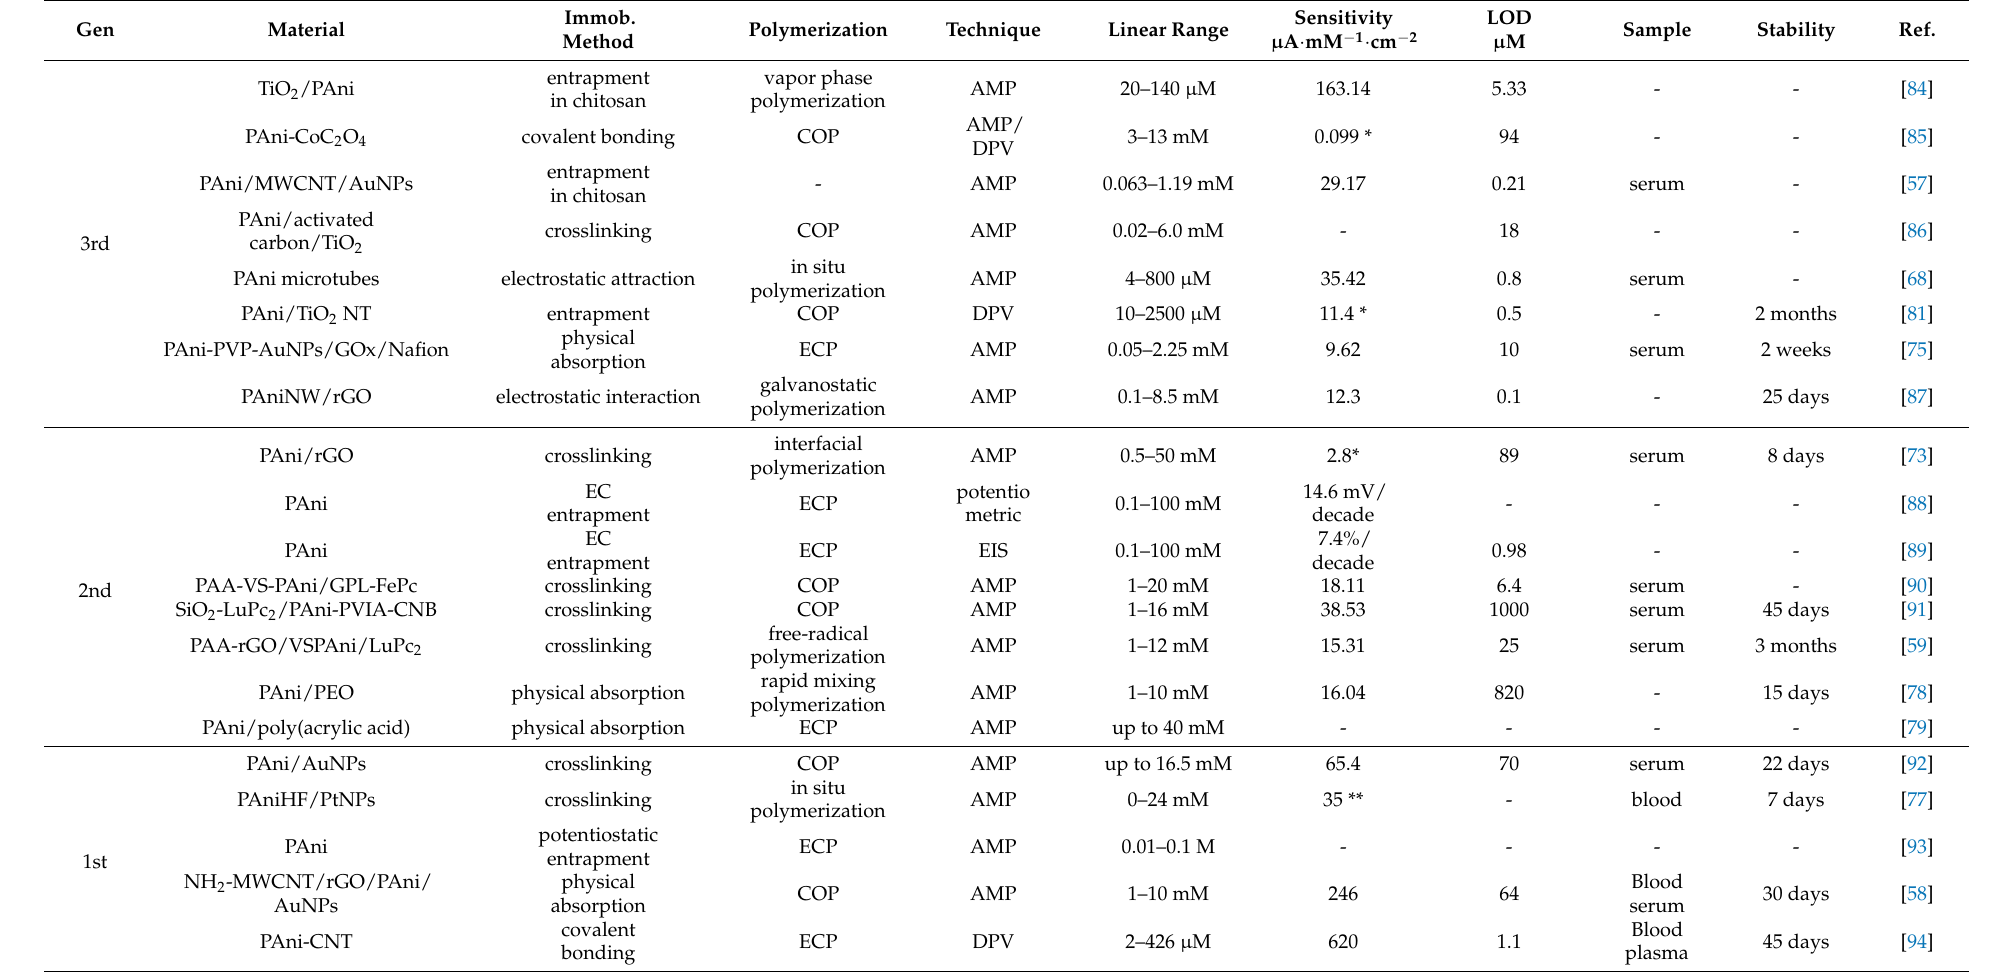
Table 1. Enzymatic PAni-based glucose sensors